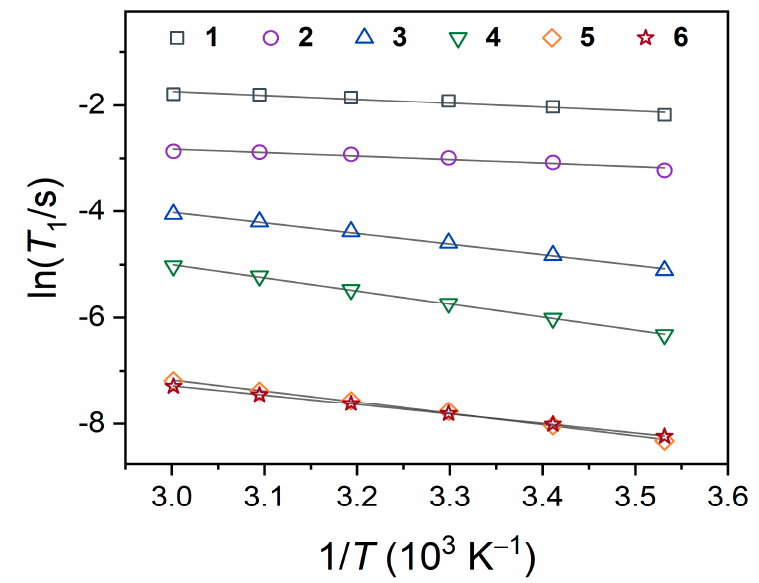
Figure 5. Arrhenius plots of variable-temperature T 1 relaxation . Solid grey lines indicate linear regressions for 1–6 . Values of R 2 from each fit (Table S2) are used to determine temperature linearity for each complex.